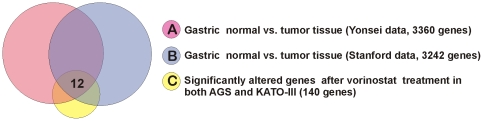
Change of gene expression signature after vorinostat treatment.Venn Diagram of genes selected by univariate test (two-sample t-test). Genes were selected for p<0.001 between compared groups. The red circle (gene list A) represents gastric cancer specific genes from Yonsei data. The blue circle (gene list B) represents gastric cancer specific genes from Stanford data. The yellow circle (gene list C) represents vorinostat specific gene signature from both AGS and KATO-III cell lines (P<0.001, 2 fold change).